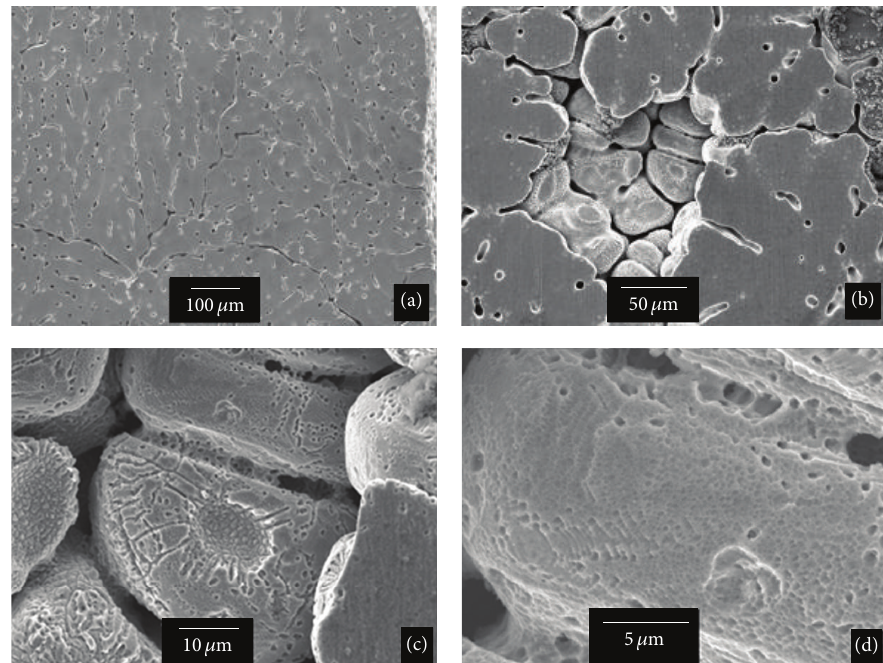
Figure5:Al-15at.%Znalloyquenchedinliquidnitrogensolutionandfreelycorrodedin1 wt.%HNO 3 solution.Zincwasselectivelydissolved creating a porous structure. (a) Aluminum-rich dendrites surrounded by voids. (b) Selective removal of zinc from interdendritic regions creating a primary porosity. (c) Resultant morphology in the walls of passivated aluminum. (d) No nanoporosity was observed in this